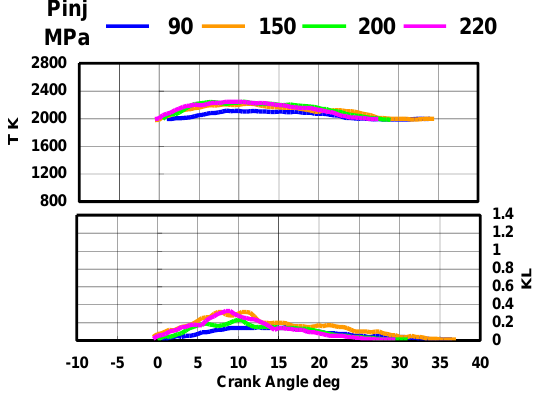
Fig. 18. Averaged Tb and KL factor by changing Pinj at EGR rate 50% Pinj is changed from 90 MPa to 150, 200 and 220 MPa at EGR rate = 50%. Although BSNOx is already low